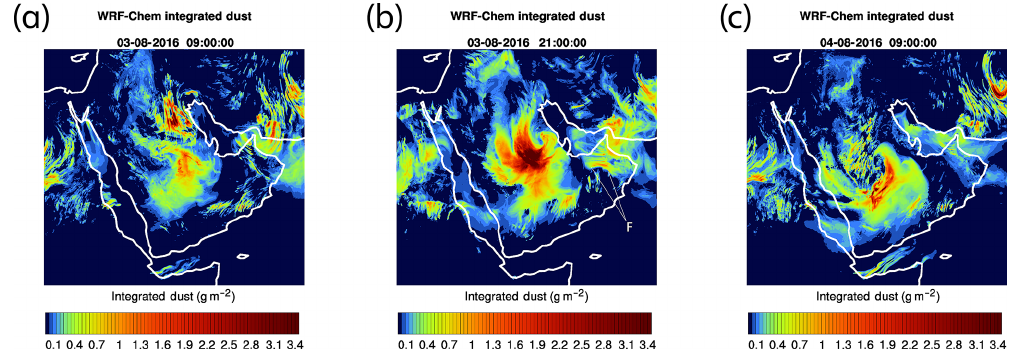
Figure 3. WRF–Chem-simulated vertically integrated dust (gm − 2 ) on the following: (a) 3 August 2016, 09:00UTC, (b) 21:00UTC, and (c) 4 August at 09:00UTC leading up to the 4 August observations of missing dust shown in Fig. 1. The feature “F” in panel (b) denotes pooling of dust along a southerly surge of air near the surface, responding to the low-pressure system in the SG.